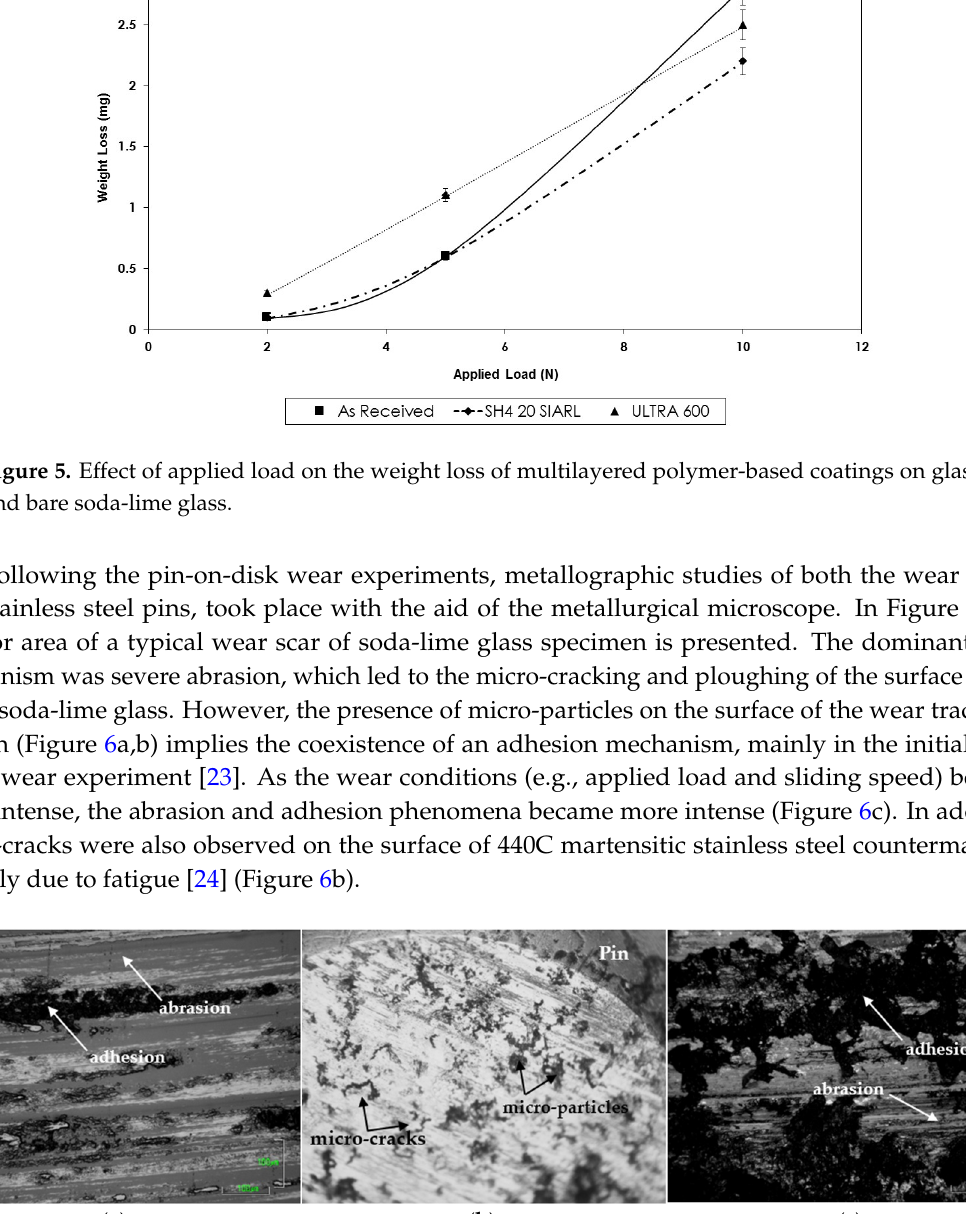
Figure 4. Effect of sliding speed on the friction coefficient of multilayered polymeric coatings and bare soda ‐ lime glass against stainless steel